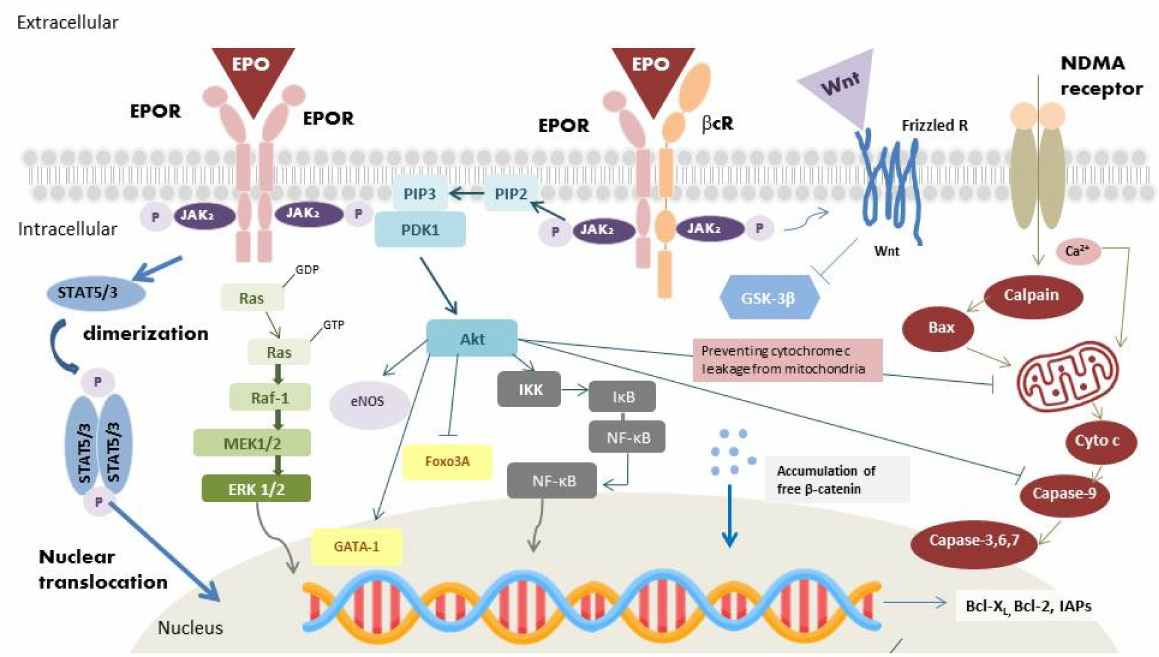
Figure 1. Binding of EPO to EPOR induces JAK-2 phosphorylation, dimerization, and subsequently activate STAT5/3, Ras/Raf/MEK/ERK, PI3-K/Akt, and NF- κ B pathways. JAK-2 phosphorylates STAT5 or STAT3, leading to the dimerization of STAT5 (STAT3). STAT5 (STAT3) and the last signaling molecule in the MAPK pathway translocate into the nucleus and upregulate the expression of antiapoptotic Bcl-2 and Bcl-xL. Activation of PI3-k/Akt pathway increases endothelial nitric oxide synthase (eNOS) protein expression and NO production, which could increase blood flow and attenuate regional injury. PI3-k/Akt pathway also phosphorylates transcription factor GATA-1